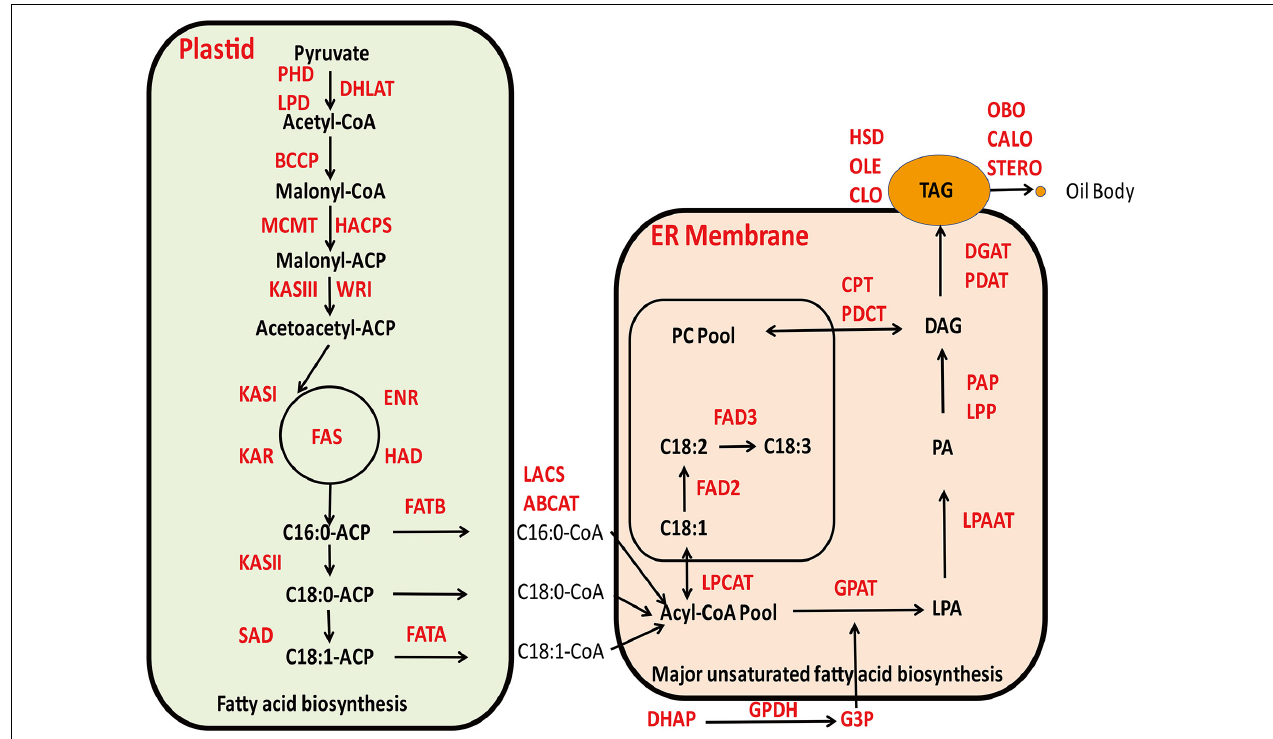
FIGURE 1 | The current understanding for the general biosynthetic pathway of cottonseed oil.